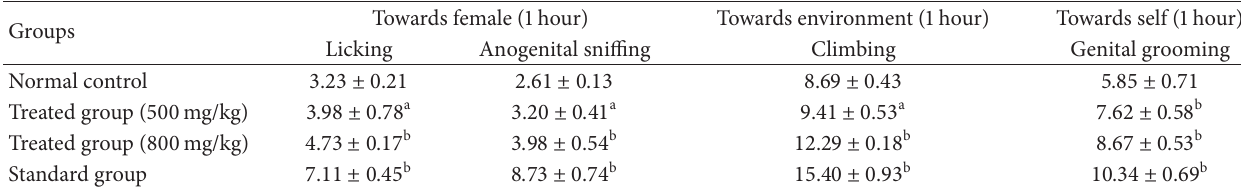
Values are mean ± standard deviation. a 𝑃 < 0.05 : significant difference when compared with the control group. b 𝑃 < 0.01 : highly significant difference when compared with the control group.